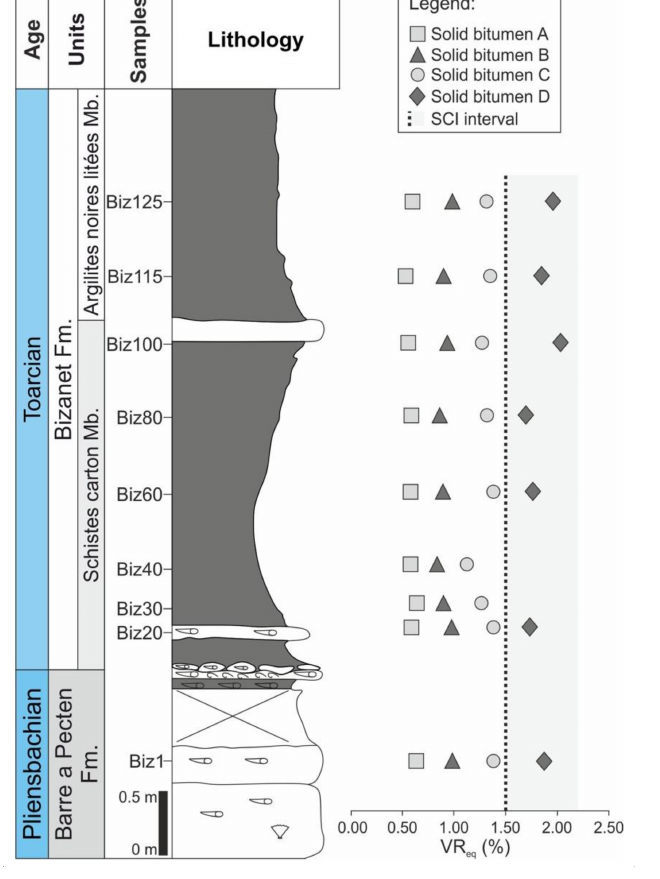
Figure 9. Vertical plot of the solid bitumen equivalent vitrinite reflectance (%) values of all the samples and the spore coloration index (SCI)